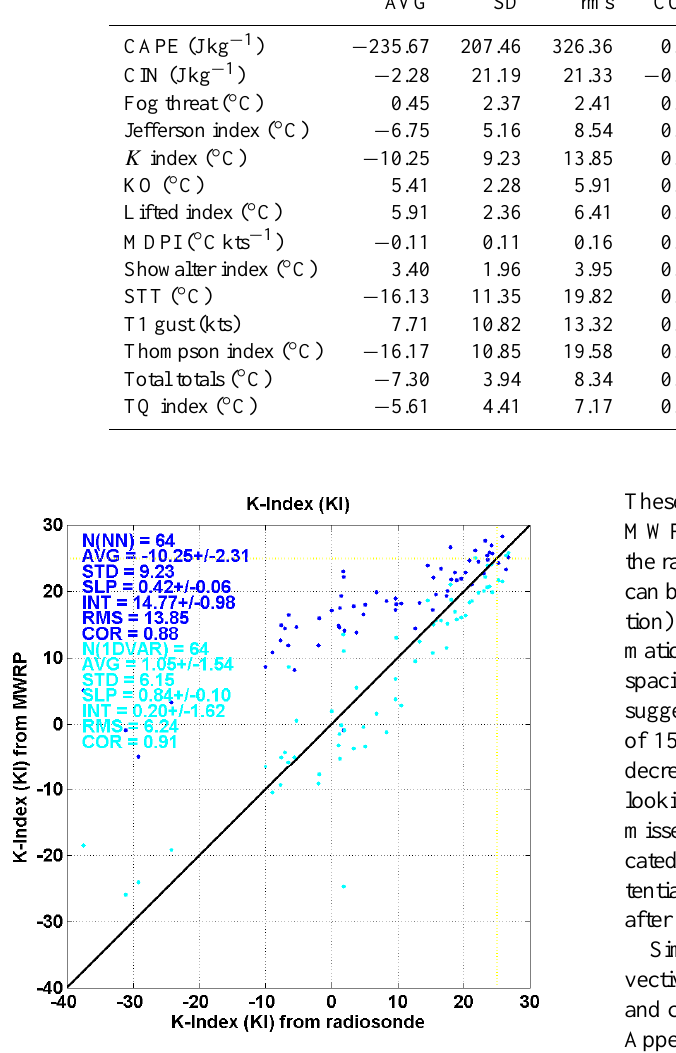
Figure 7. Scatter plot of K index values computed from radiosonde and MWRP-retrieved profiles (NNz in blue, 1-DVAR in cyan) and respective statistics: average (AVG), standard deviation (SD), and root-mean-square (rms) differences, correlation coefficient (COR), slope (SLP), and intercept (INT) of a least-square linear fit. AVG, SD, INT, and rms are in kelvin. SLP and COR are unitless. Numbers after the ± sign indicate the 95% confidence